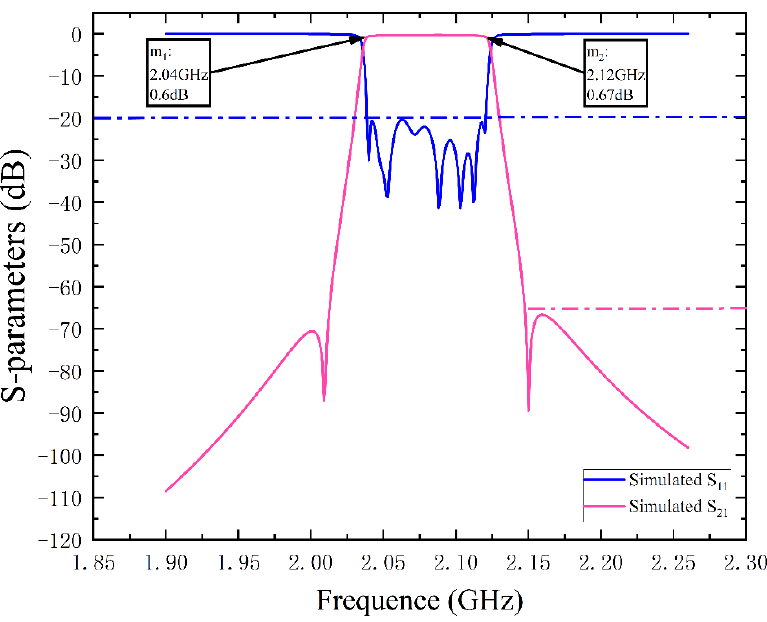
Figure 7. Frequency response of 2080 MHz simulation model.